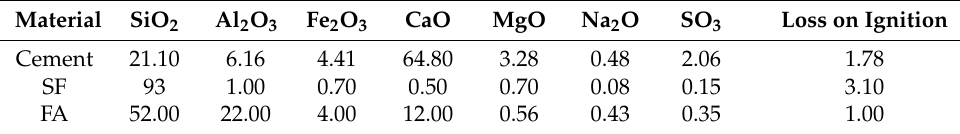
Table 1. Chemical composition of cementitious materials (wt%).